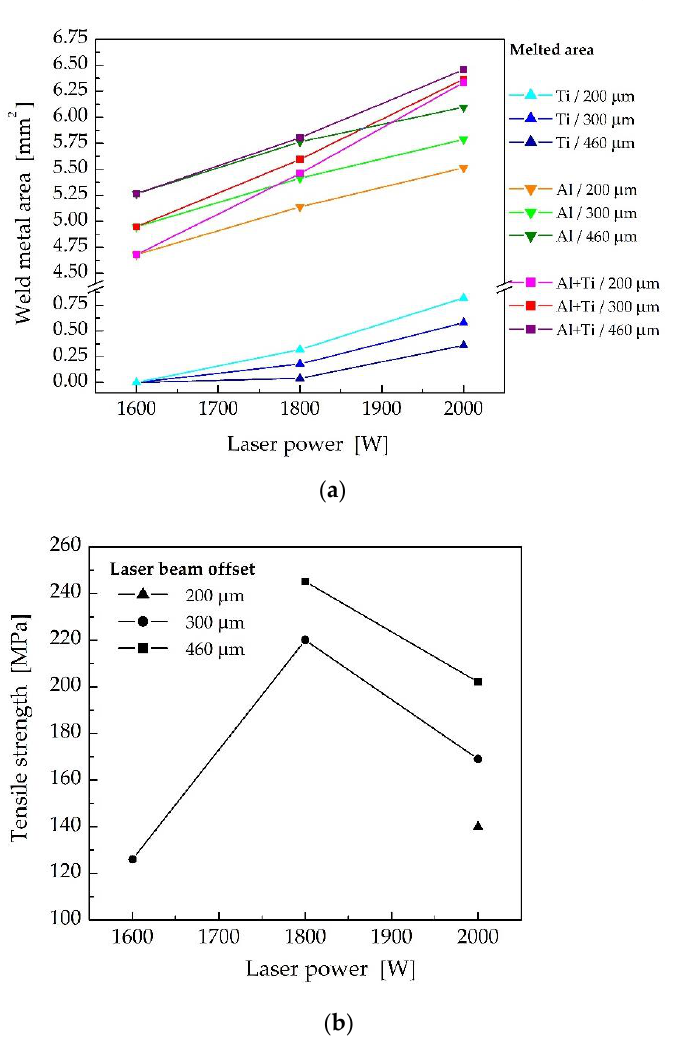
Figure 14. Effect of laser power ( a ) on the weld metal area and ( b ) on the ultimate tensile strength of